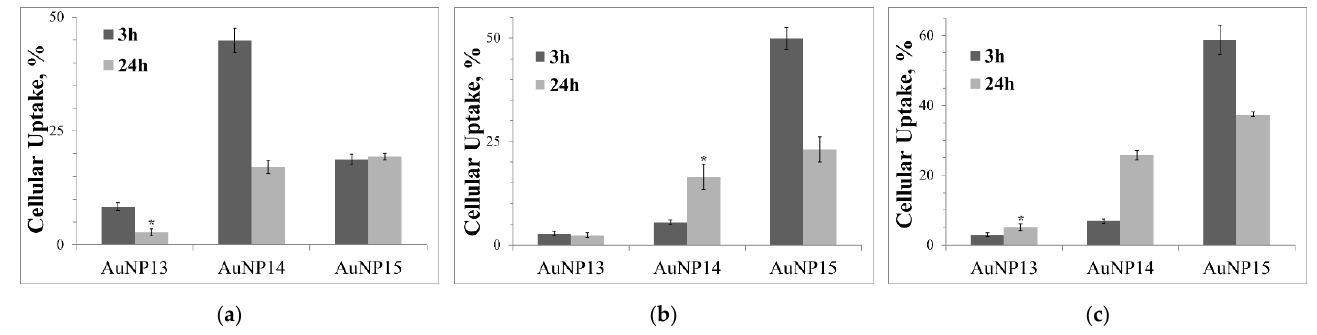
Figure 3. Cellular uptake of complexes with optimal concentrations of AuNP after 3 and 24 hours of incubation in ( a ) HeLa, ( b ) HL-60, and ( c ) CEM-SS. Cells were treated with 100 µg/mL for AuNP13; 25 µg/mL for AuNP14; 10 µg/mL for AuNP15. Used siRNA is rndRNA-FAM (100 nM). Data obtained based on fluorescence intensity from FAM-labeled RNA by flow cytometry. Statistical significance between 3 and 24 h (at * p < 0.001) was estimated by the post-hoc Newman–Keuls test.